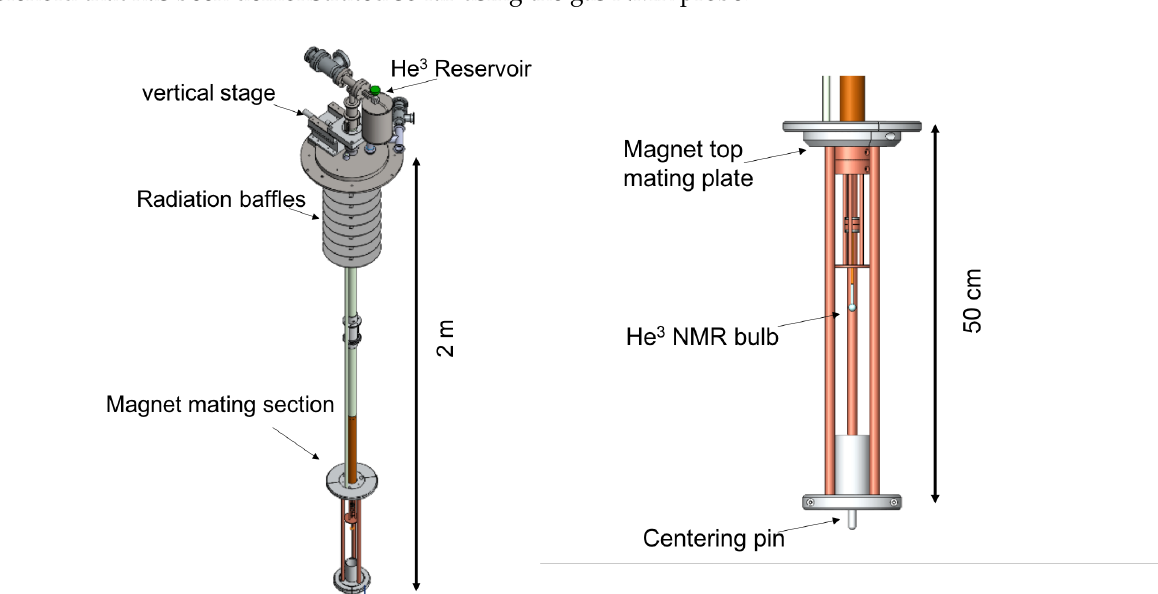
Figure 8. ( left ) The 3 He NMR probe assembly is centered in the solenoid dewar via the centering pin. The probe and be raised, lowered, and rotated; ( right ) close up of the 1 cm diameter 3 He bulb that is connected via a capillary to a large room temperature